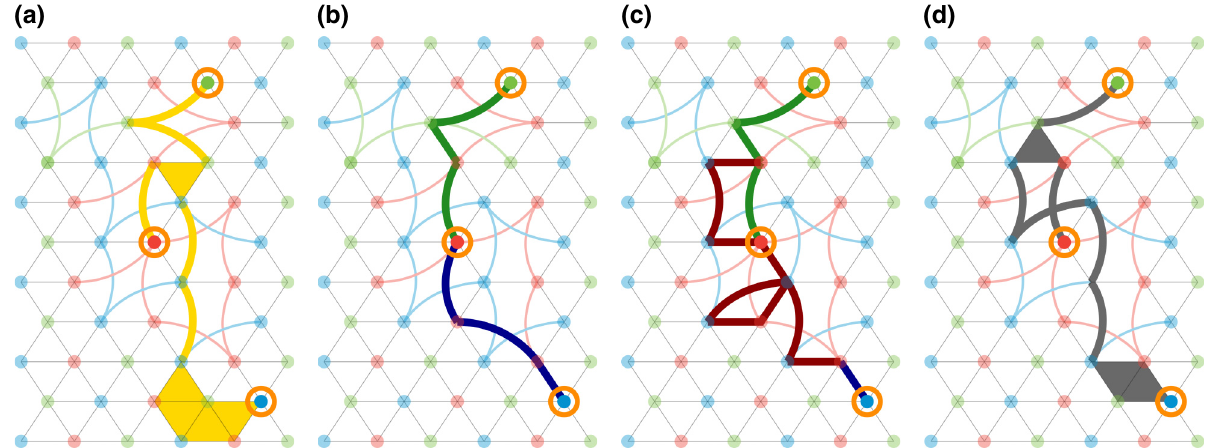
FIG. 7. An illustration of our decoding algorithm for HCT codes. (a) A phase-flip error (yellow faces and edges) and its syndrome (ringed vertices). (b)–(d) The three steps of the HCT-code decoder: (1) matching—use MWPM to compute a matching (dark green (cid:5) L rb (cid:5) L rg and ; (2) local modification—locally modify the matching (new edges and blue edges) of the syndrome in the restricted lattices included in the matching are highlighted in red); (3) local lift—use the local-lifting procedure to compute a correction (gray faces and edges) from the modified